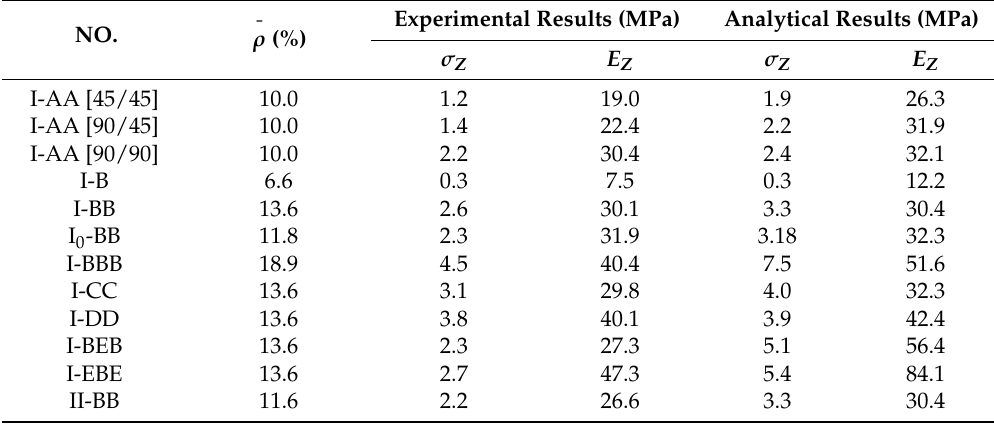
Table 3. Experimental results and analytical results of a single-layer structure.